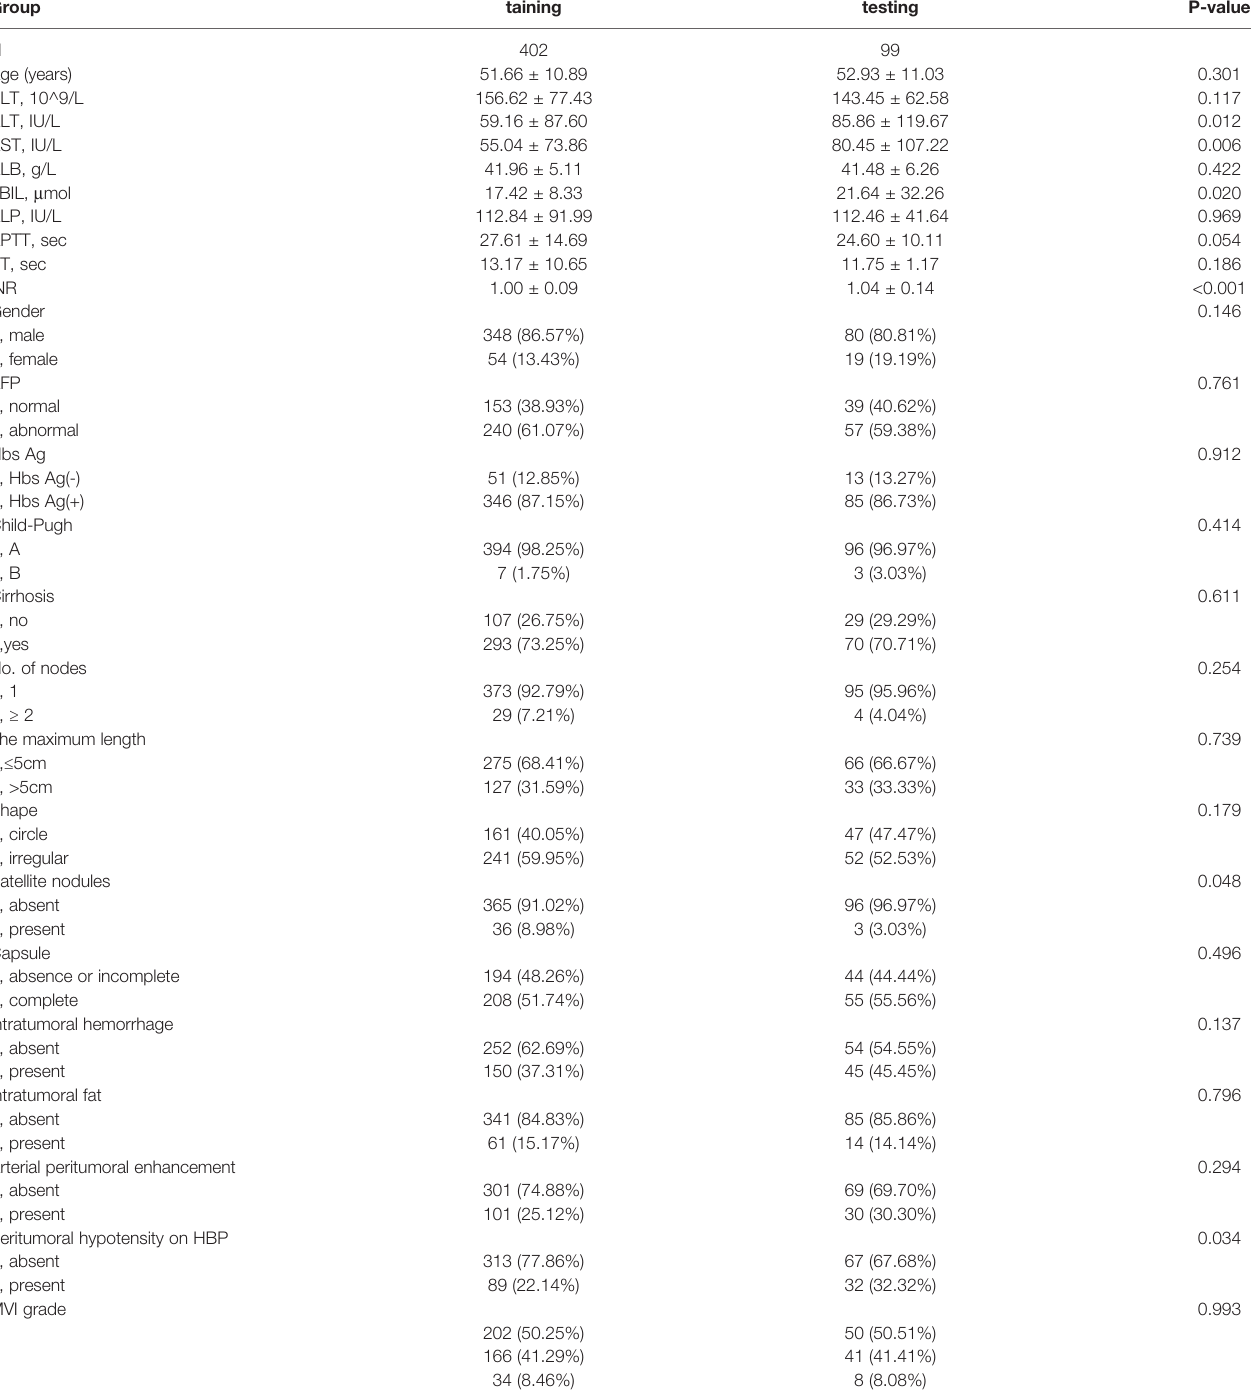
TABLE 2 | The differences of clinicoradiological characteristics in between training and testing datasets.